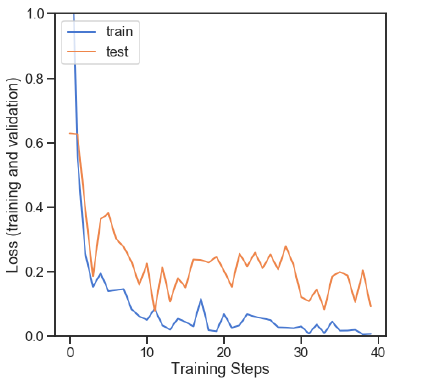
Figure 12. The loss function of the worst case in Table